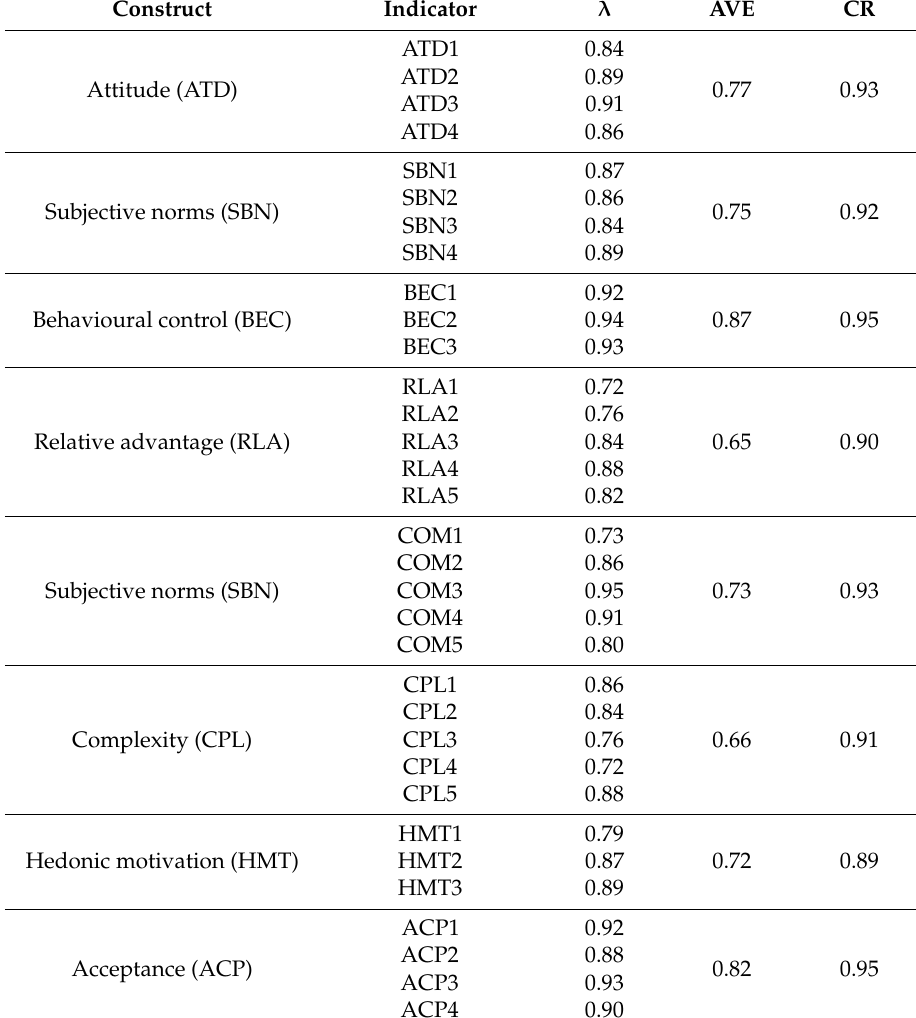
Table 3. Confirmatory factor